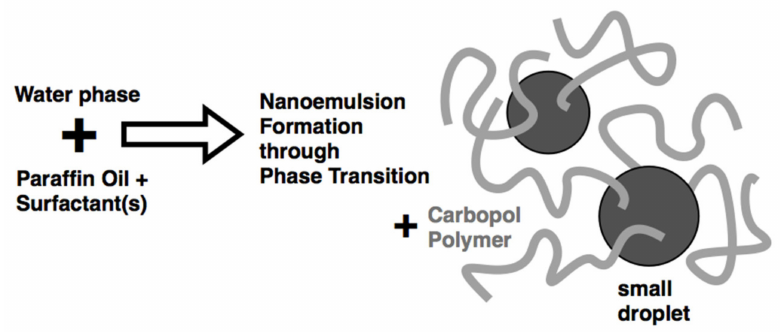
Figure 21. Scheme of the proposed microstructure and mechanism of stabilization of the cream [410].